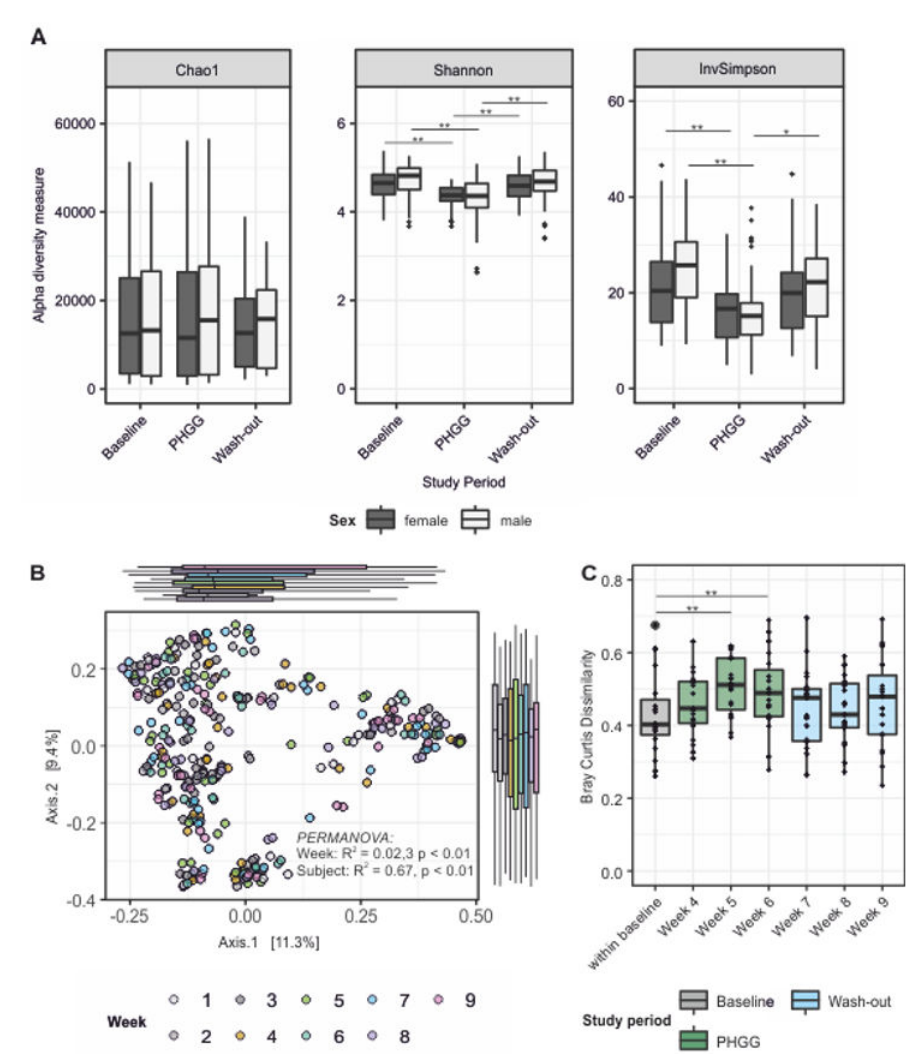
Figure 2. Impact of PHGG supplementation on intestinal microbiota composition. ( A ) α -diversity decreases during intervention in both sexes and returns to baseline during the washout period (pairwise Wilcoxon Test). ( B ) Principal component analysis of microbial compositions over time; study week (i.e., PHGG supplementation status) as determinant was significant (PERMANOVA permutational analysis of variance). ( C ) Pairwise analyses of Bray–Curtis dissimilarities over time (Wilcoxon test). PHGG = partially hydrolyzed guar gum; * p < 0.05, ** p <